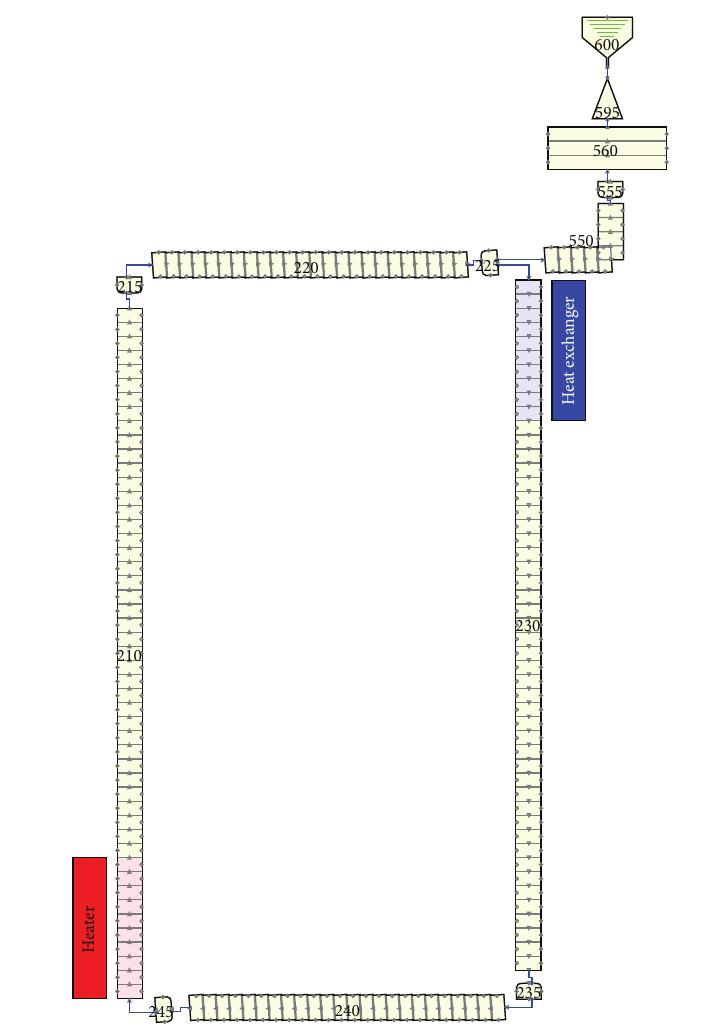
Figure 21: Natural circulation system